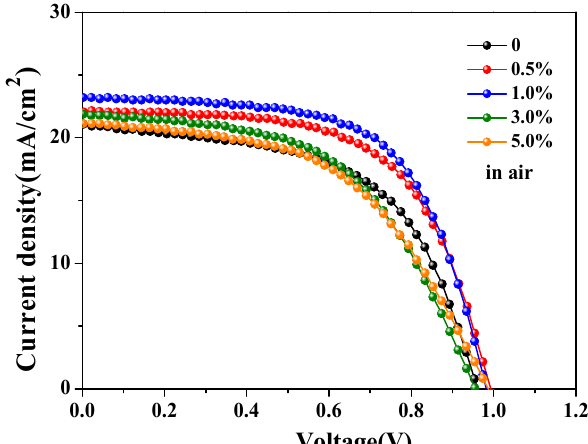
Figure 6. J-V curves of perovskite solar cells based on the FTO/c-TiO 2 /m-TiO 2 /perovskite/ spiro- OMeTAD /Ag. Table 1. Photovoltaic performances summary of the perovskite devices.